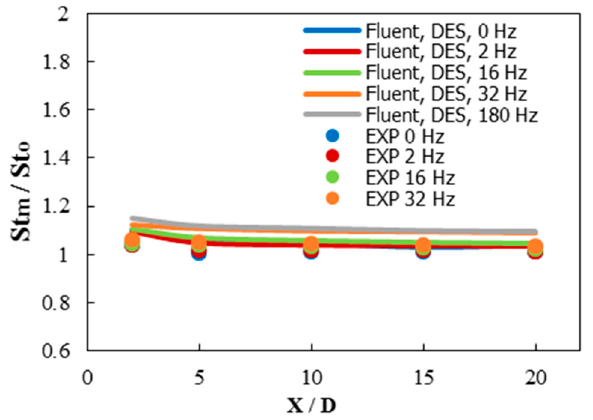
Figure 19. The spanwise-averaged Stanton number ratio obtained using the DES Realizable k - ε model for M = 0.5 for the 0, 2, 16, 32, and 180 Hz oscillations.